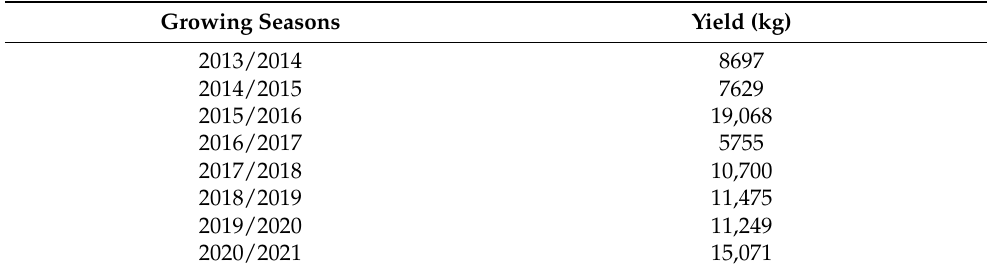
Table 1. Historical yield data of the olive orchard studied.